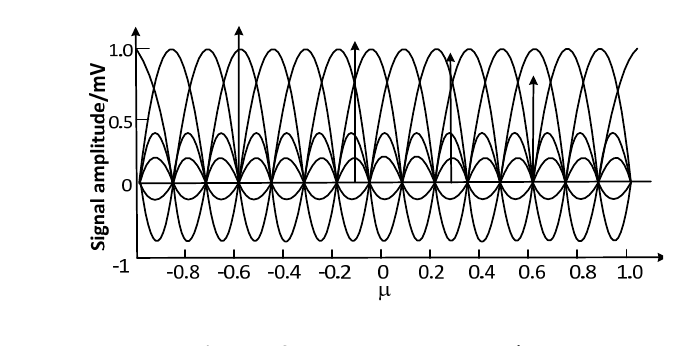
Figure 2. Beam space matrix.